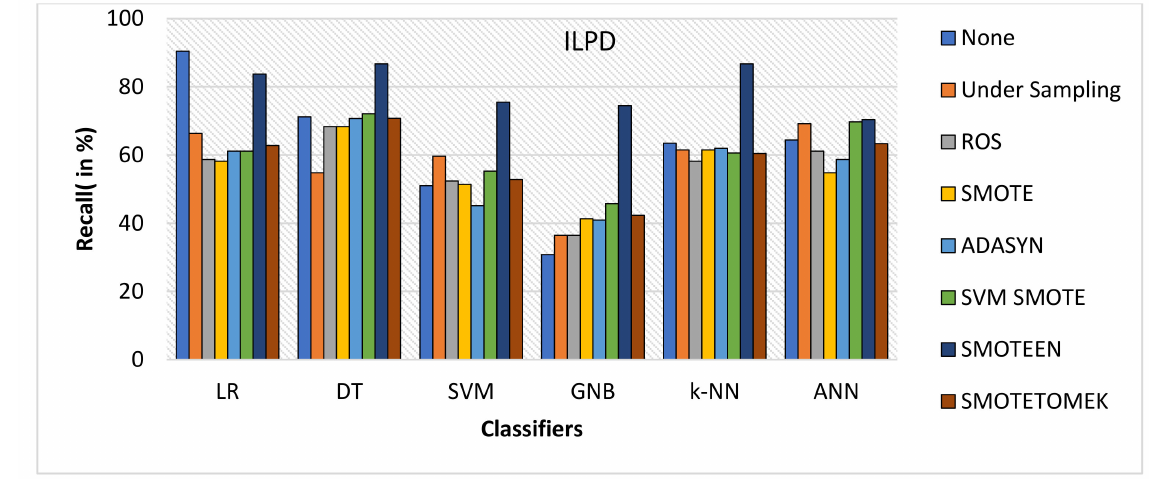
Figure 12. Recall for ILPD dataset of balancing algorithms over six classifiers.